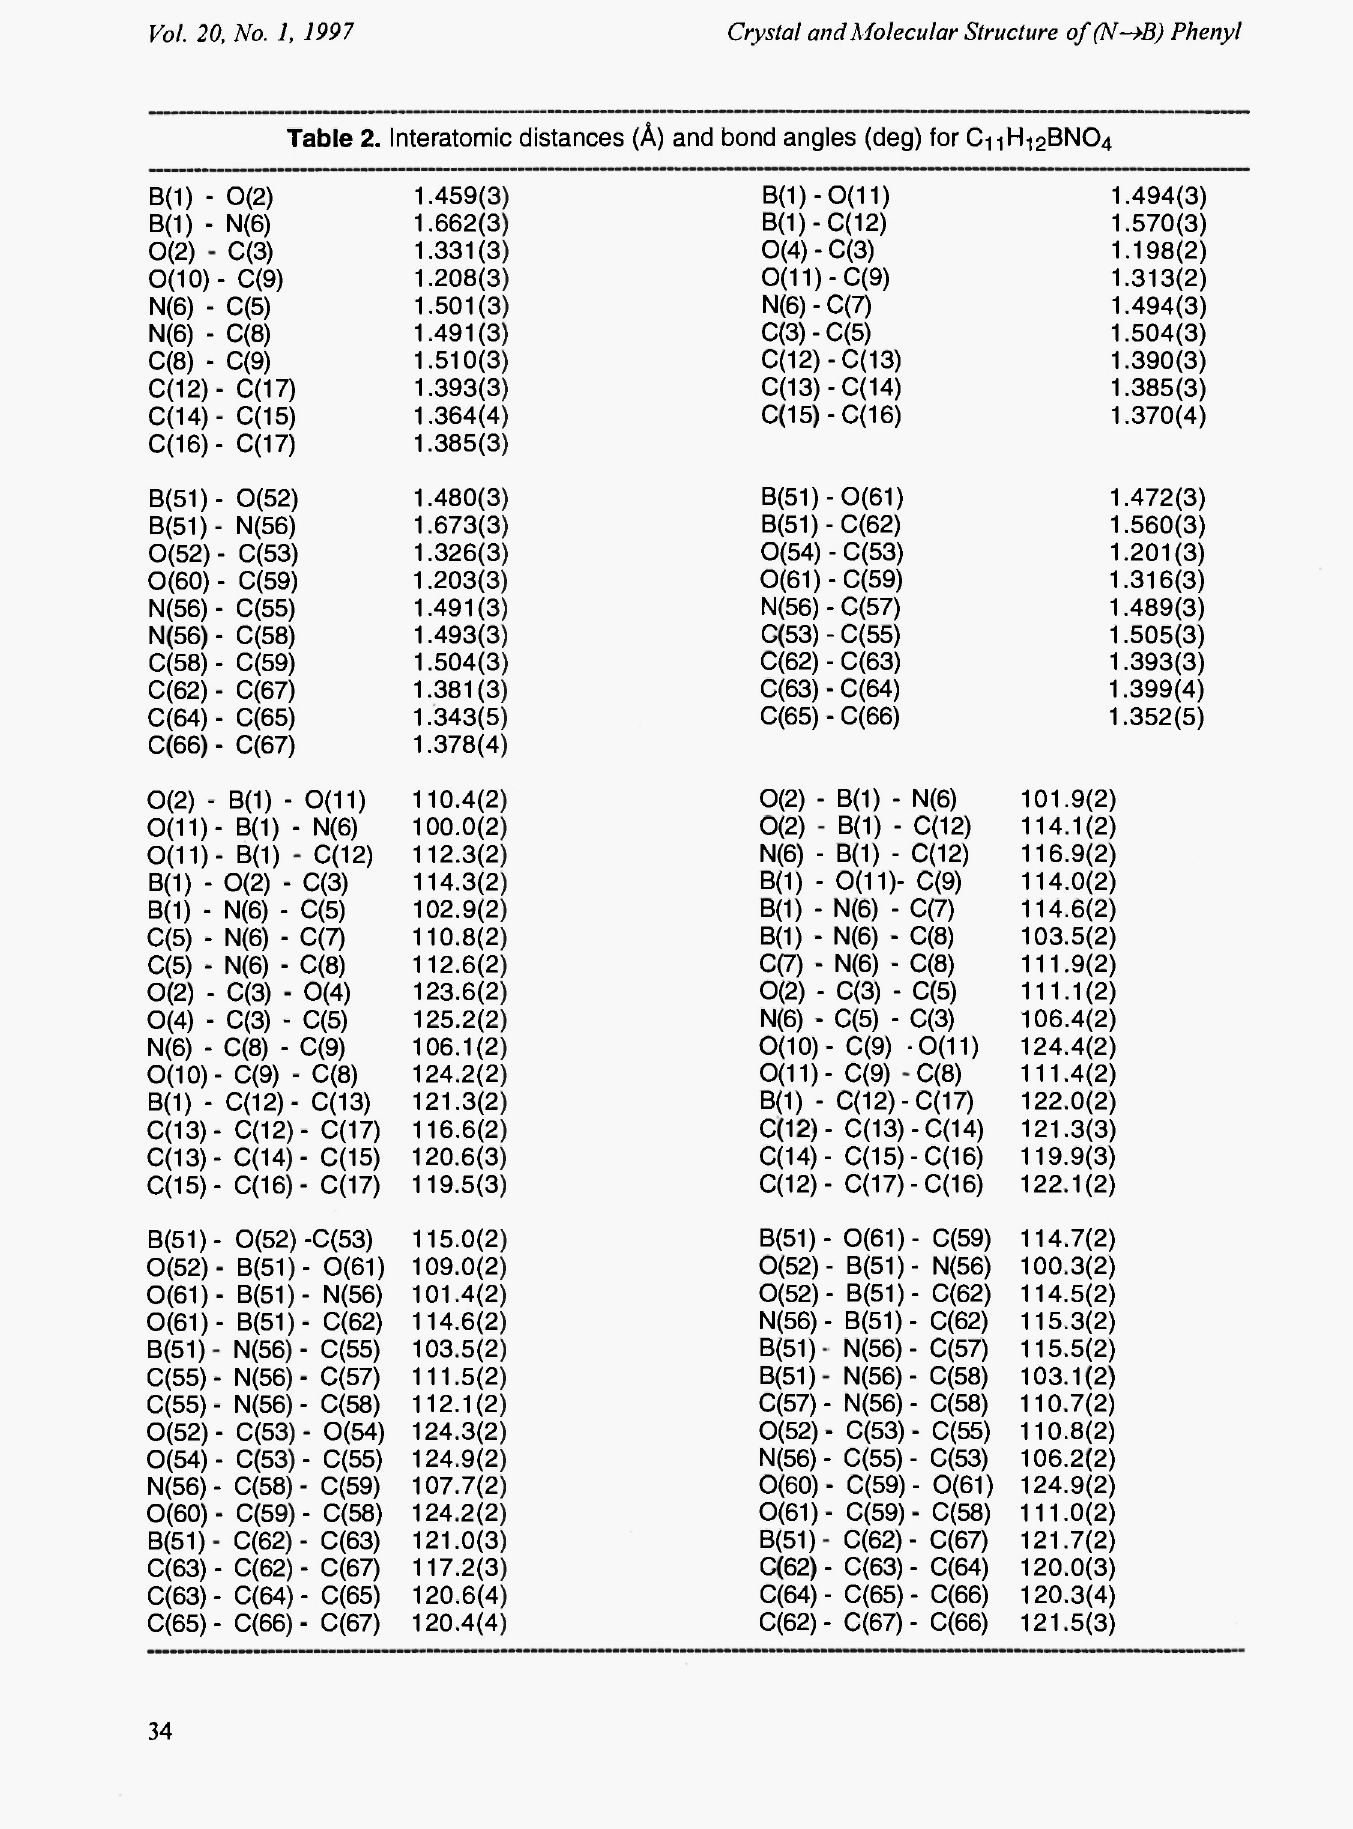
Table 2. Interatomic distances (Ä) and bond angles (deg) for